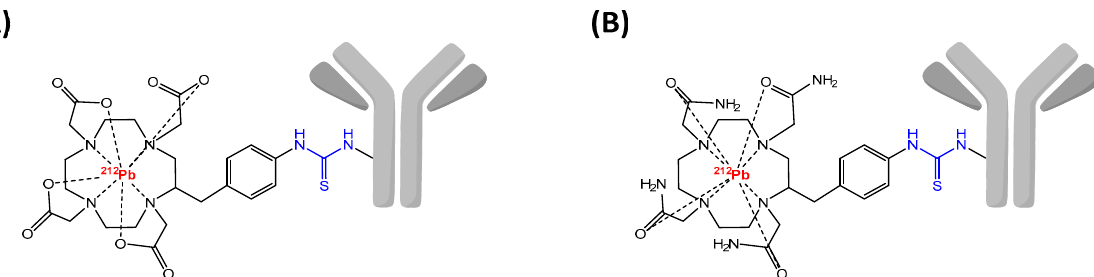
Figure 7. Schematic representation of 212 Pb-labeled radioimmunoconjugates based on p -SCN-Bn-DOTA ( A ) or p -SCN-Bn- TCMC ( B ).